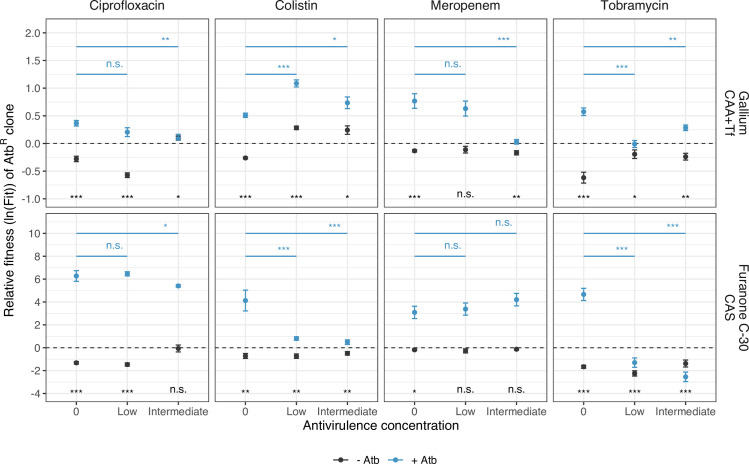
Effect of combination treatment on the relative fitness of AtbR clones.Test of whether antivirulence compounds alone or in combination with antibiotics can abrogate or revert selection for antibiotic resistance. All AtbR clones were competed against the susceptible WT for 24 hours, starting at a 1:9 ratio. The dashed lines denote fitness parity, where none of the competing strains has a fitness advantage. In the absence of any treatment, all AtbR clones showed a fitness disadvantage (fitness values < 0) compared to the WT, demonstrating the cost of resistance. When treated with antivirulence compounds alone, the AtbR clones did not experience any selective advantage in 14 out of 16 cases (exception: colistin-gallium combinations). When treated with antibiotics alone, all AtbR clones experienced significant fitness advantages (fitness values > 0), as expected. When antivirulence compounds were added as adjuvants to antibiotics, the fitness advantage of AtbR clones was reduced, abrogated, or reversed for six out of eight drug combinations. All data are shown as means ± standard errors across a minimum of 16 replicates from 4 to 7 independent experiments. Significance levels are based on t tests or ANOVAs: n.s. = non-significant; *p < 0.05; **p < 0.01; ***p < 0.001. See S1 Table for full details on the statistical analyses. The underlying data for this figure can be found at https://doi.org/10.6084/m9.figshare.12515364. - Atb, treatments without antibiotics; + Atb, treatments with antibiotics; AtbR clones, antibiotic resistant clones; CAA, casamino acid medium; CAS, casein medium; Tf, human apo-transferrin; WT, wild-type.